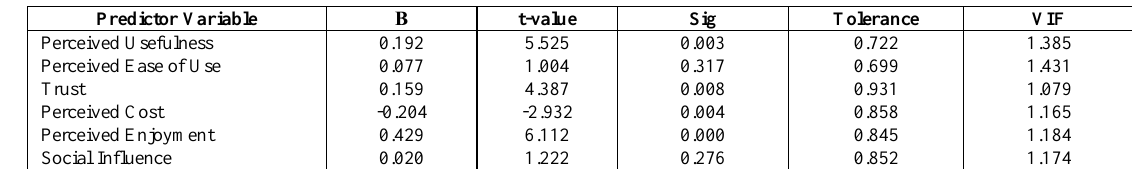
Table 5. Multiple regression